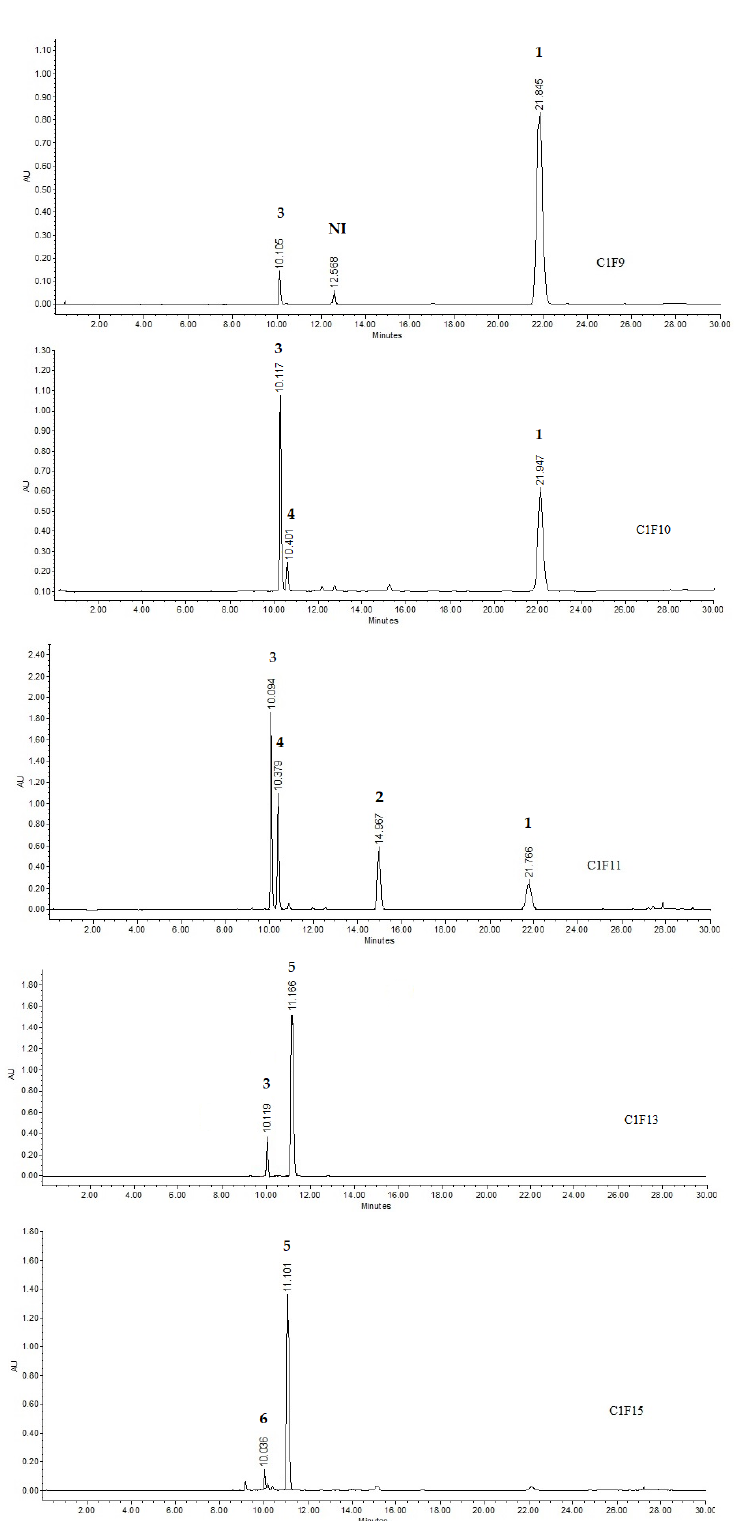
Figure 2. HPLC analysis of subfractions obtained from EtOAc-F, indicating the presence of kaempferol ( 1 ), quercetin ( 2 ), coumaric acid ( 3 ), ferulic acid ( 4 ), luteolin 7-O-rhamnoside ( 5 ), quercetin 3-O-rhamnoside ( 6 ) and caffeoyl derivate (NI). NI not identified.